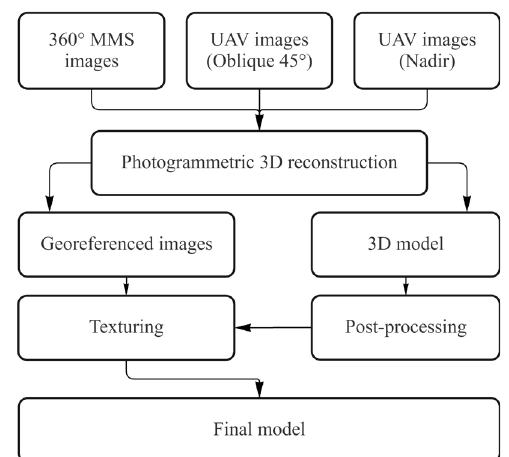
Figure 3. Reconstruction and modelling workflow for urban 3D models from MMS, oblique and nadir UAV